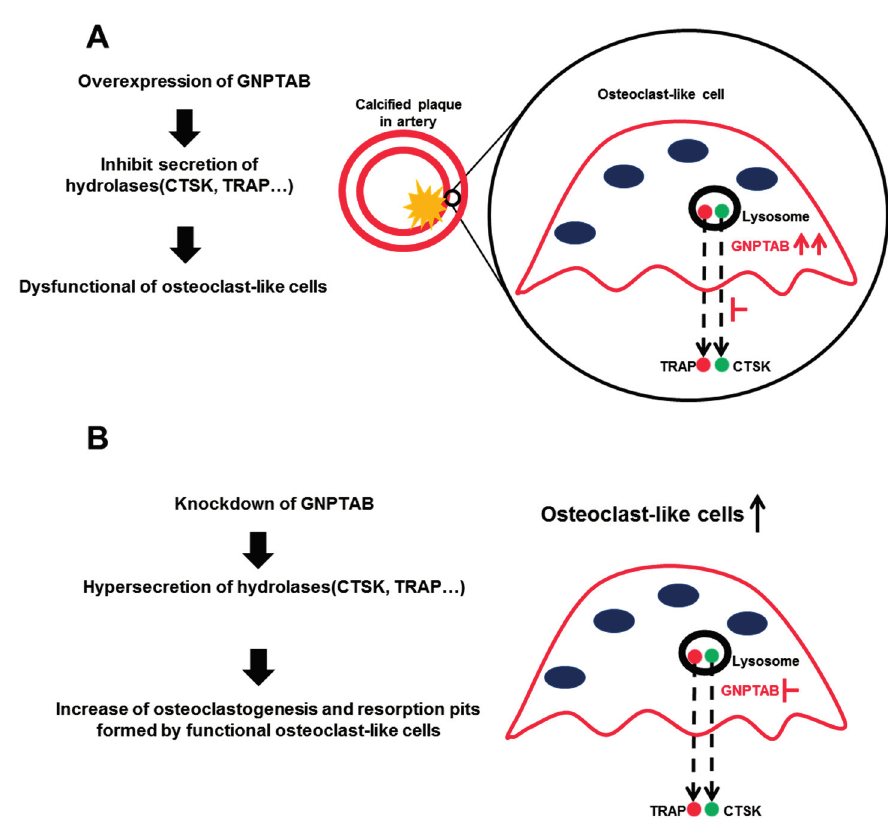
Figure 6. Proposed mechanisms of GNPTAB on regulating of osteoclast function. ( A ) High levels of GNPTAB around calcified areas in atherosclerotic plaques inhibit secretion of lysosomal hydrolases such as CTSK and TRAP, which causes dysfunction of osteoclast-like cells followed by lack of resolution of vascular calcification; (B ) Silencing of